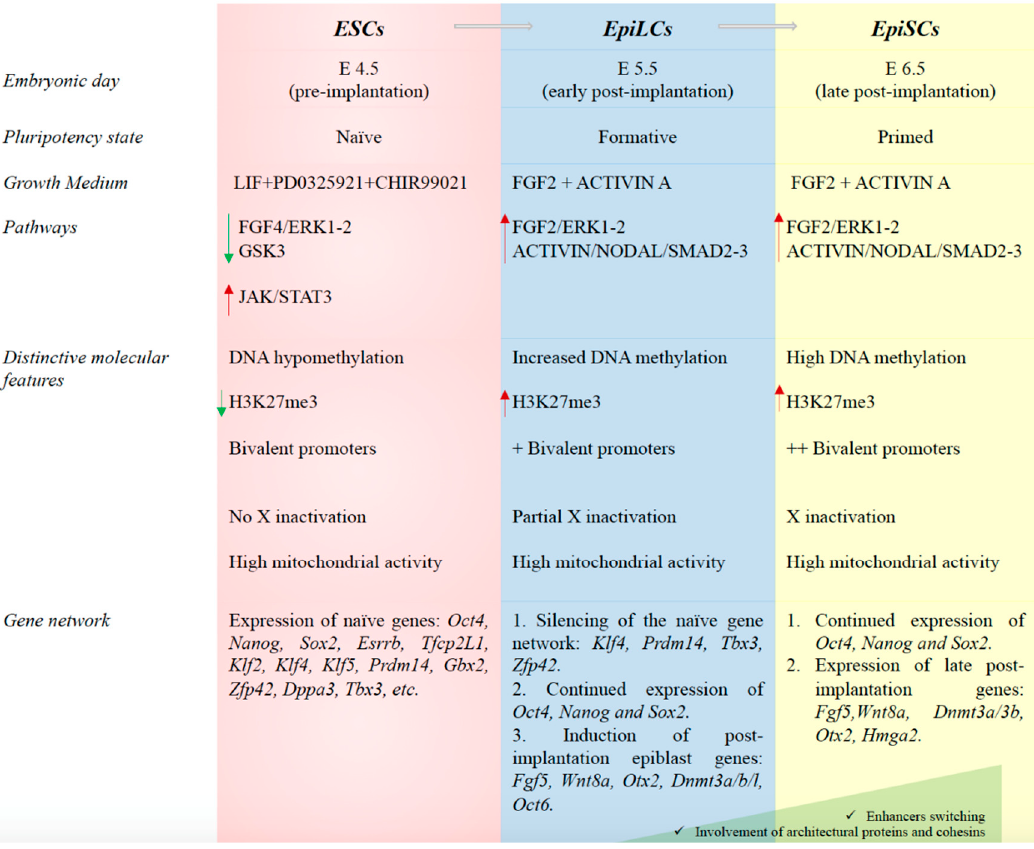
Figure 2. The different stages of pluripotency. Brief summary of the main molecular features defining the embryonic stem cells in the naïve, formative and primed states of pluripotency.